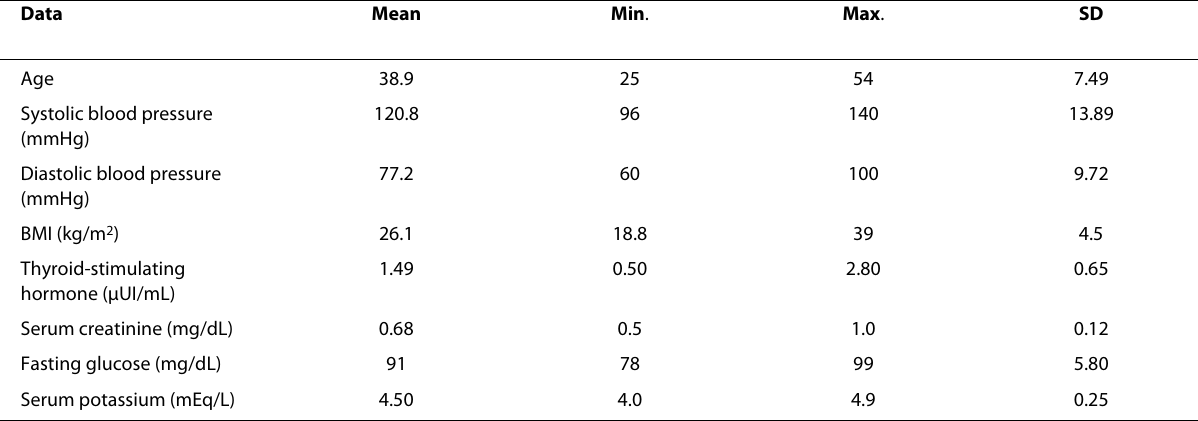
Table 2: Age, blood pressure, body mass index (BMI), and laboratory assessment of patients (n = 20; 19 female)